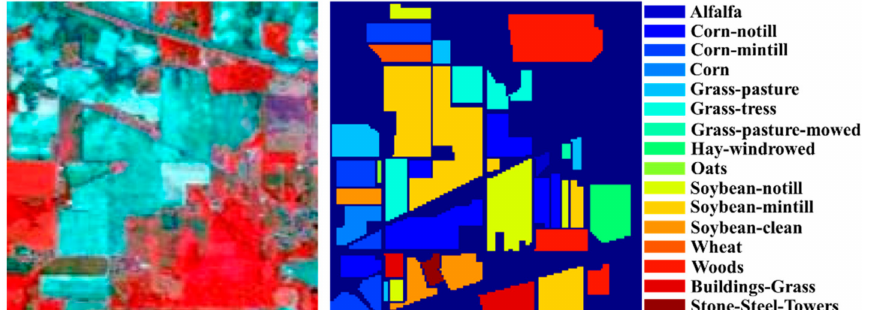
Figure 6. The false color image and ground truth map of the Indian Pines dataset. The original image size is 145 × 145